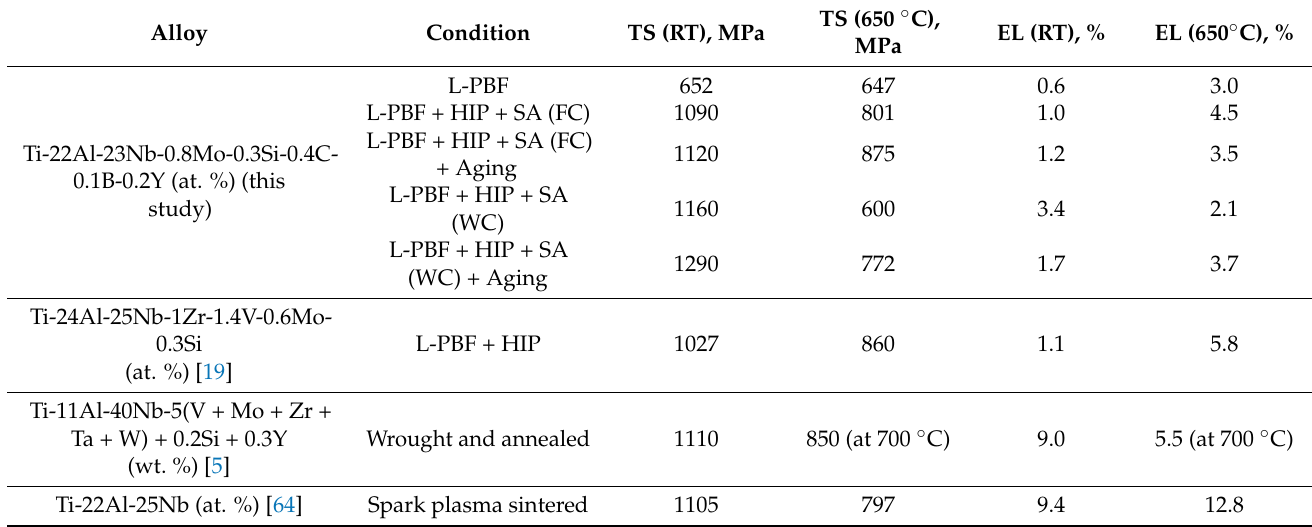
Table 5. Tensile mechanical properties of Ti 2 AlNb-based